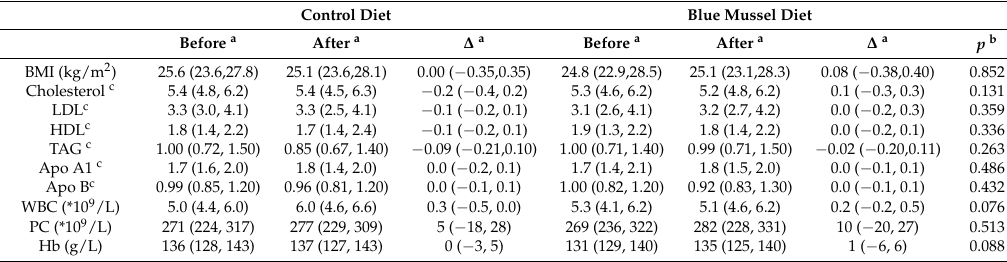
Table 6. Blue mussel diet versus control diet in blood lipids, blood count, hemoglobin and BMI. Control Diet Blue Mussel Diet Before a After a ∆ a Before a After a ∆